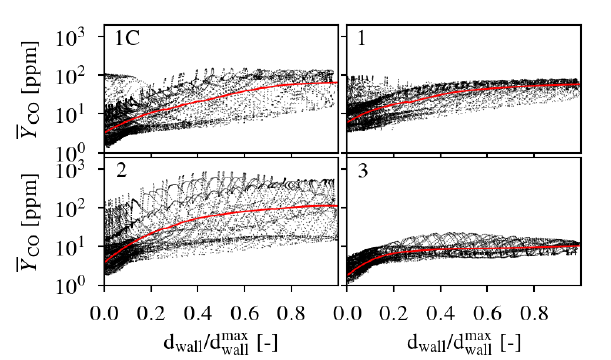
Figure 9. Scatter of the mean carbon monoxide mass fraction over normalized wall distance d wall /d max at the combustor exit cross section for cases 1C, 1, 2, and 3. The red solid line shows wall the conditional